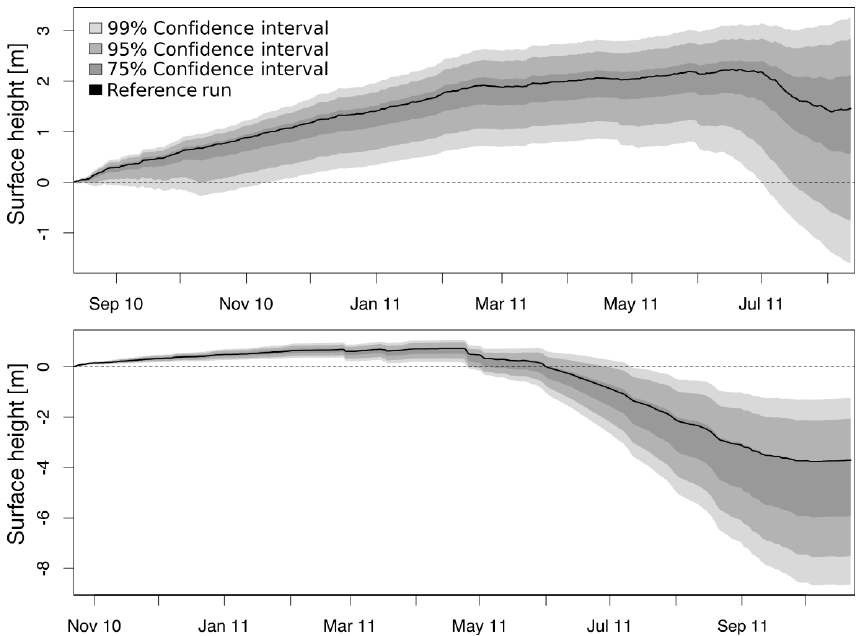
Figure 3. Spread of the ensemble simulation at KNG8 (upper panel) and KNG1 (lower panel) due to propagating uncertainties in the model inputs. The black lines represent the reference run. The intervals show the 99, 95, and 75% quantiles estimated from the quasi-random Monte Carlo runs (20000 ensemble members). Note the different horizontal and vertical scales.